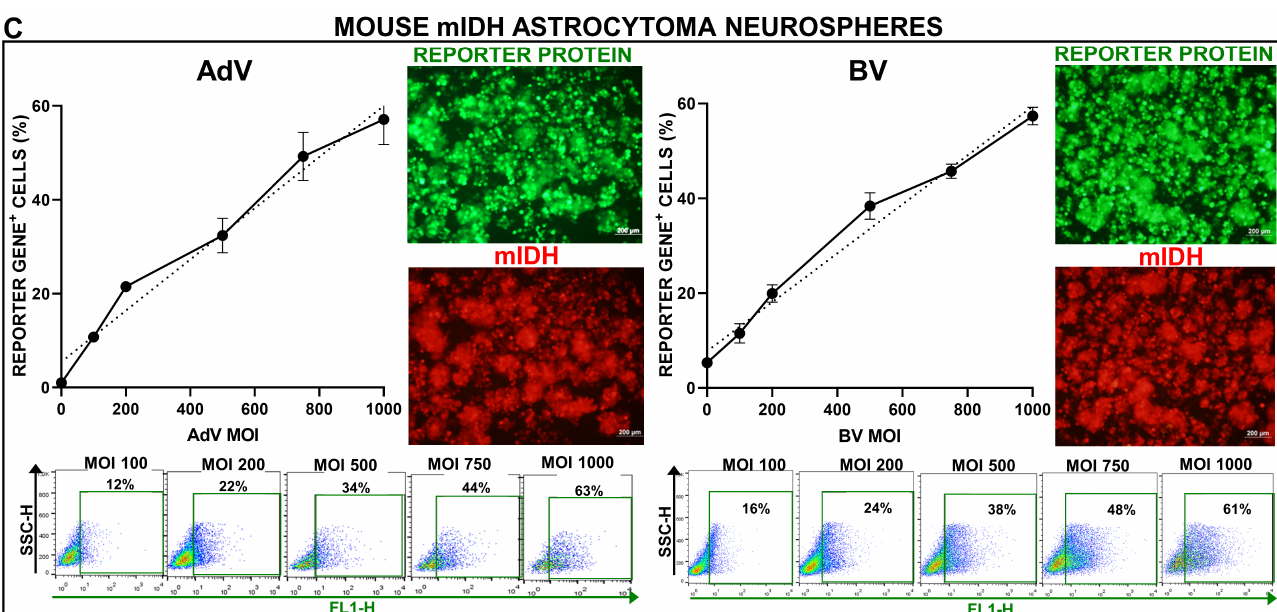
Figure 4. AdV and BV transduction efficiency in mouse normal and neoplastic astrocytes in vitro. GL26 mouse GBM cells ( A ), primary cultures of normal astrocytes from mouse brain cortex ( B ) and Katushka+ mouse mIDH astrocytoma neurospheres ( C ) were incubated with AdV or BV at different MOIs, and 48 h later, transgene expression was assessed by fluorescent microscopy and quantified by flow cytometry. Graphs show the transduction efficiency of each vector at different MOIs, as assessed by flow cytometry. Light gray lines indicate the percentage of living cells at each MOI compared to mock controls, as assessed by MTT assay. Representative microphotographs are shown (MOI = 750). Nuclei were stained with DAPI ( A , B ) or Katushka expression ( C ) was used to identify